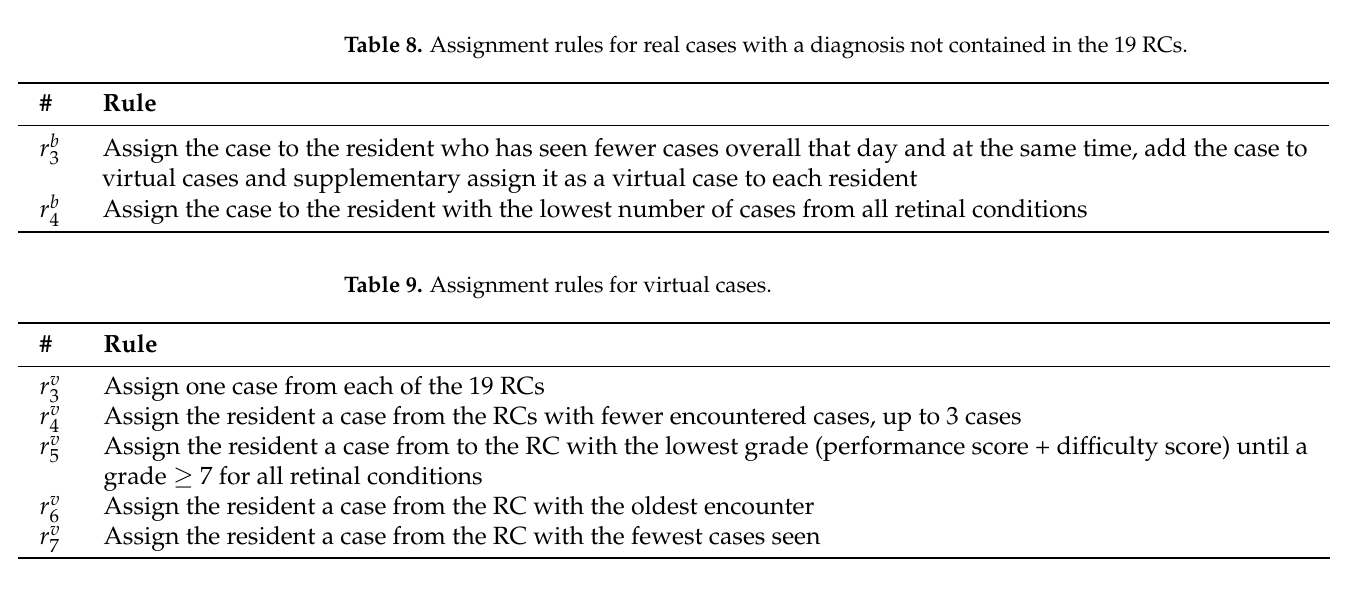
Table 10. Assignment rules for supplementary virtual